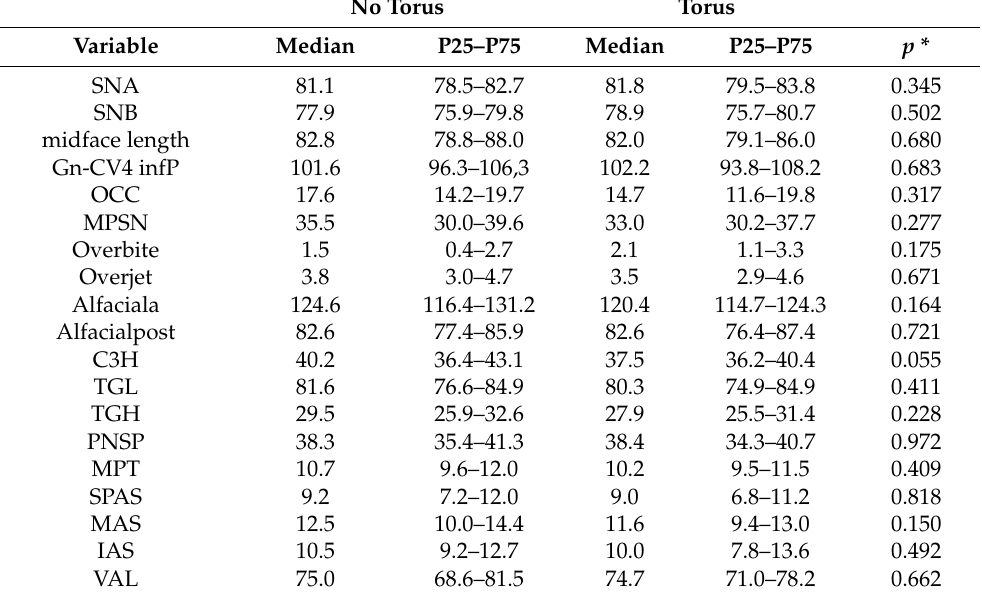
Table 7. Comparison of cephalometric values according to the presence of a mandibular torus.